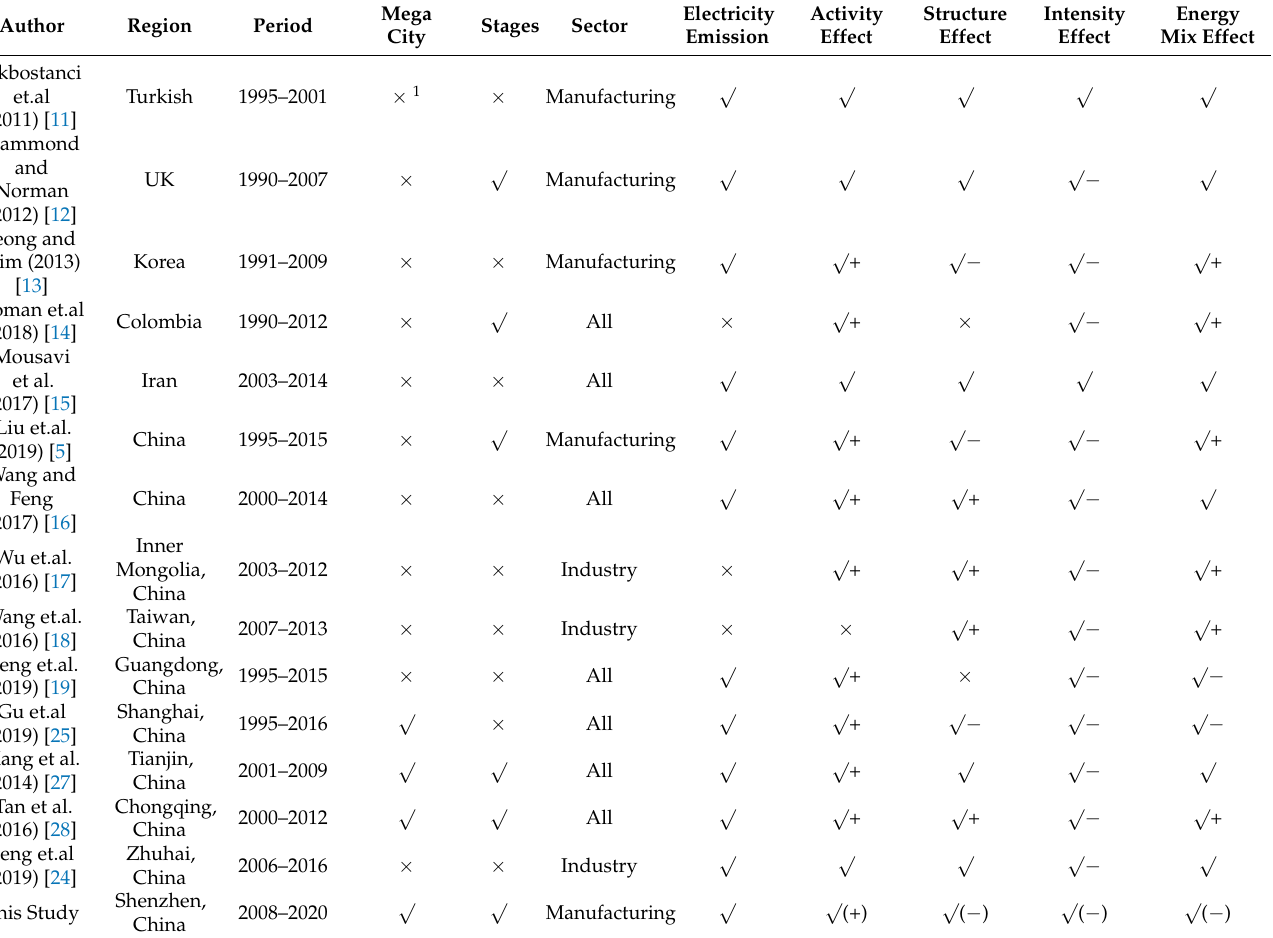
Table 1. Representative studies of CO 2 emission changes using the LMDI